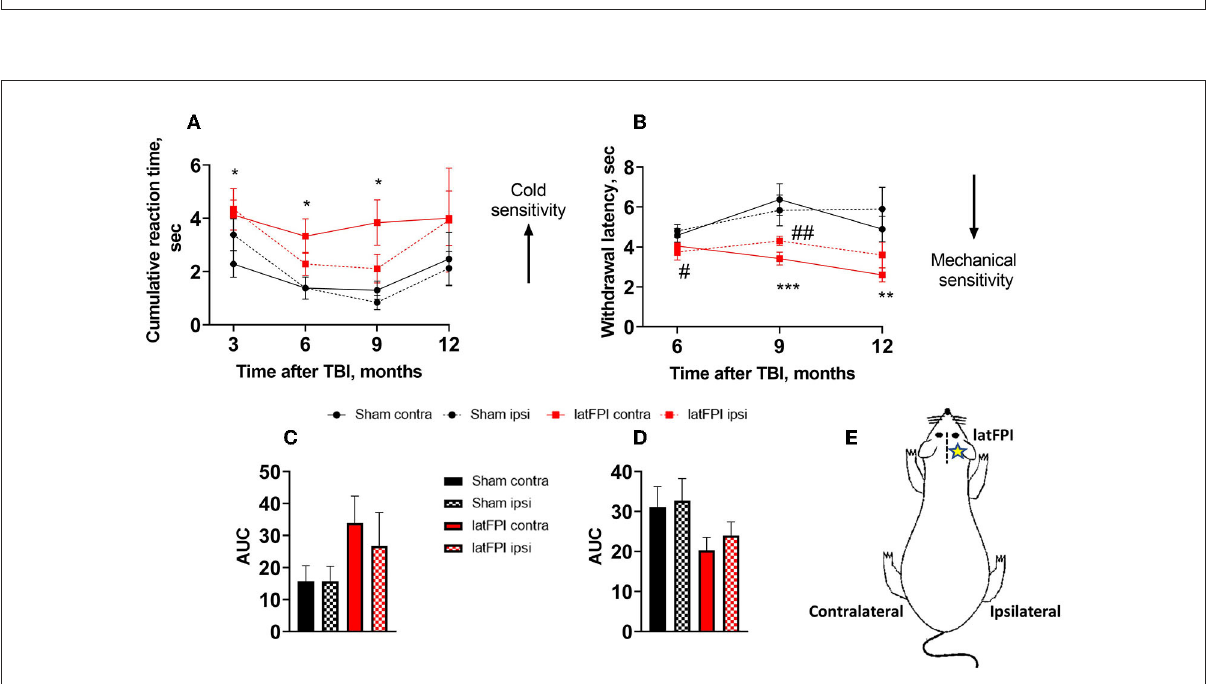
FIGURE3 Cold and mechanical sensitivity following latFPI in mice. The cumulative reaction time of contralateral and ipsilateral hind paw licking or shaking in the acetone test (A) and latency of contralateral and ipsilateral hind paw withdrawal in the electronic von Frey test (B) were recorded 3, 6, 9, and 12 months post-injury. Data are expressed as mean ± SEM. * p < 0.05; ** p < 0.001 contralateral latFPI vs. contralateral sham hind paw. # p < 0.05; ## p < 0.001 ipsilateral latFPI vs. ipsilateral sham hind paw (two-way RM ANOVA followed by Fisher’s LSD test). The area under the curve (AUC) in the acetone (C) and von Frey tests (D) . The AUC was calculated over the whole post-injury period. Schematic drawing of contralateral and ipsilateral sides. The contralateral hind paw corresponds to the opposite side of the lesion, and the ipsilateral hind paw corresponds to the lesion side (E) . Data are expressed as mean ± SEM. * p < 0.05; ** p < 0.01; *** p < 0.01 vs. sham group (one-way ANOVA followed by Dunnett’s